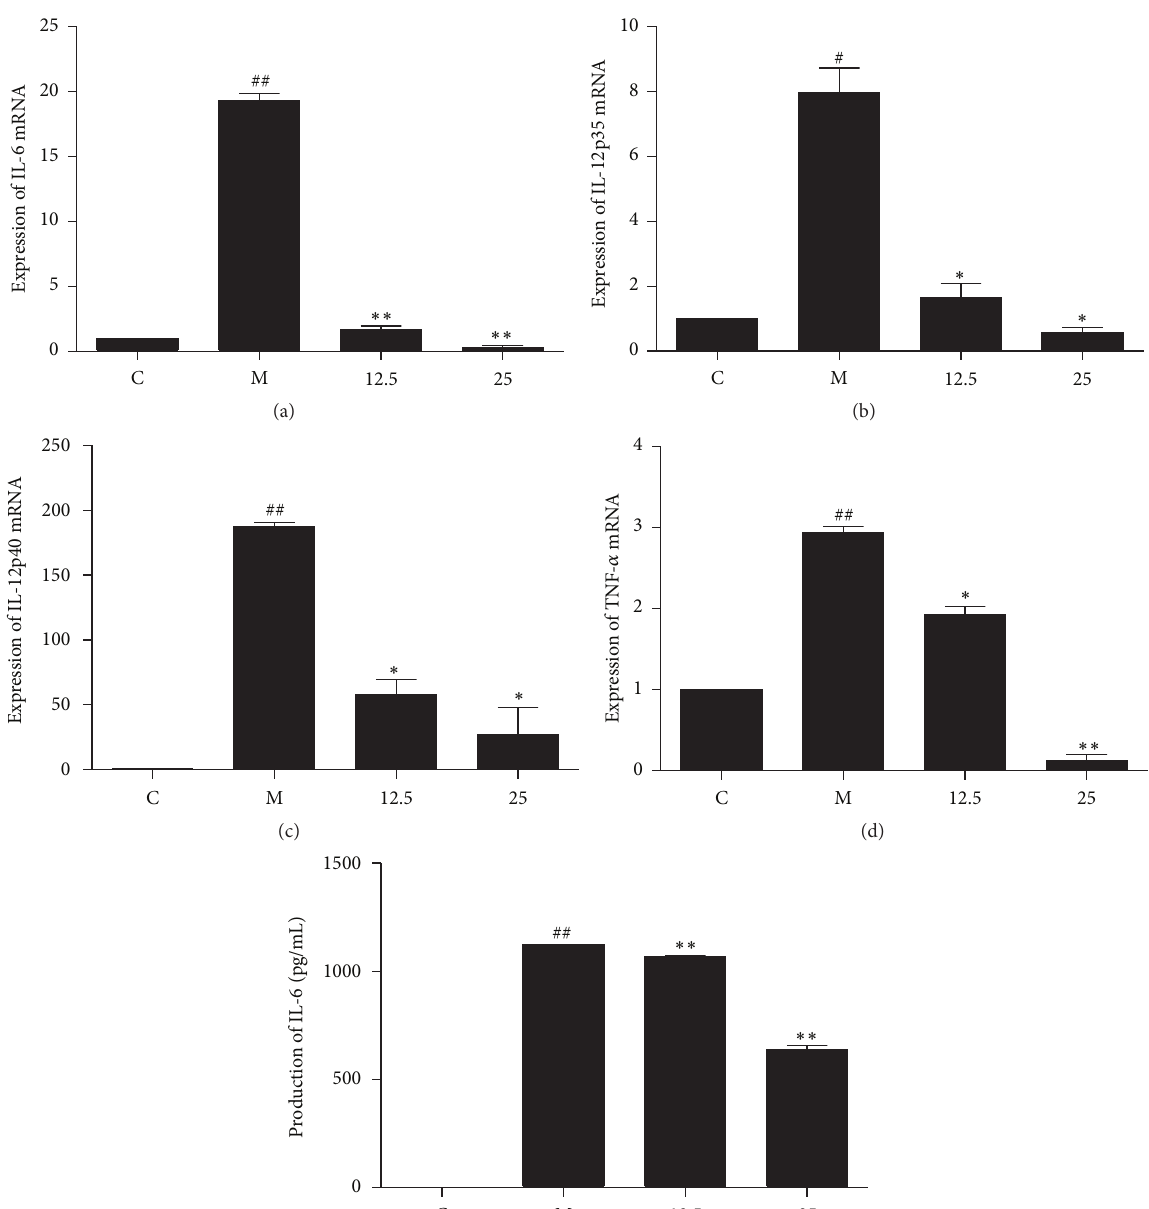
Figure 4: Effect of TIE on proinflammatory cytokines in LPS/IFN 𝛾 -stimulated RAW264.7 cells. (a, b, c) RAW264.7 cells (1 × 10 6 cells/dish) were treated with varying doses of TIE with IFN 𝛾 (10U/mL) plus LPS (100ng/mL) for 4h. Total RNA was isolated and subjected to qRT-PCR to determine the level of IL-6 and IL-12p35/p40 mRNA. (d, e) RAW264.7 cells were treated with IFN 𝛾 (10U/mL) plus LPS (100 ng/mL) in the presence of varying concentrations of TIE for 24 h. Total RNA was isolated and subjected to qRT-PCR to determine the level of TNF- 𝛼 mRNA. Conditioned media were collected and subjected to ELISA to determine the amount of IL-6. The values (means ± SEM) were obtained from three independent experiments. ## 𝑃 < 0.01 , # 𝑃 < 0.05 versus control group; ∗∗ 𝑃 < 0.01 , ∗ 𝑃 < 0.05 versus model